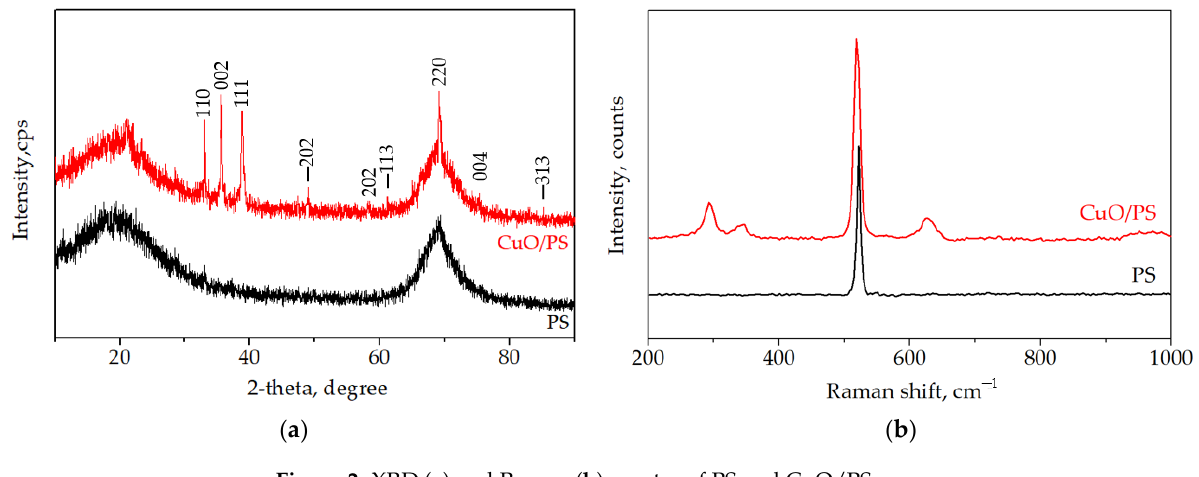
Figure 2. XRD ( a ) and Raman ( b ) spectra of PS and CuO/PS.